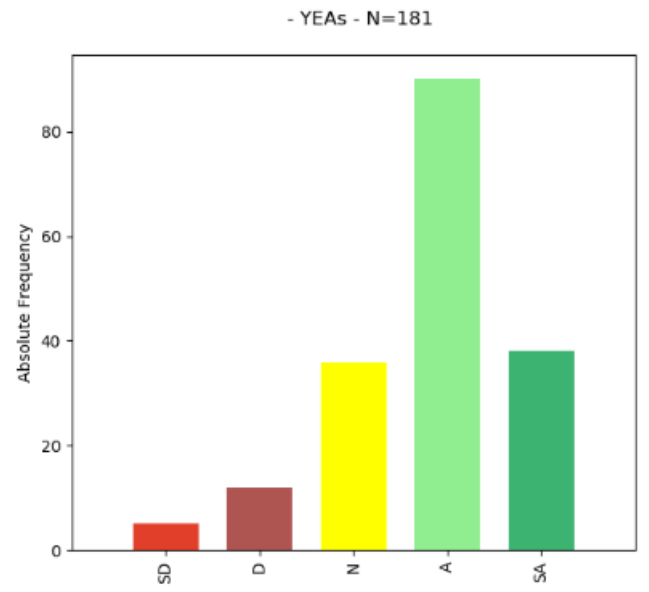
Fig. 8. STEP and YAEs on local